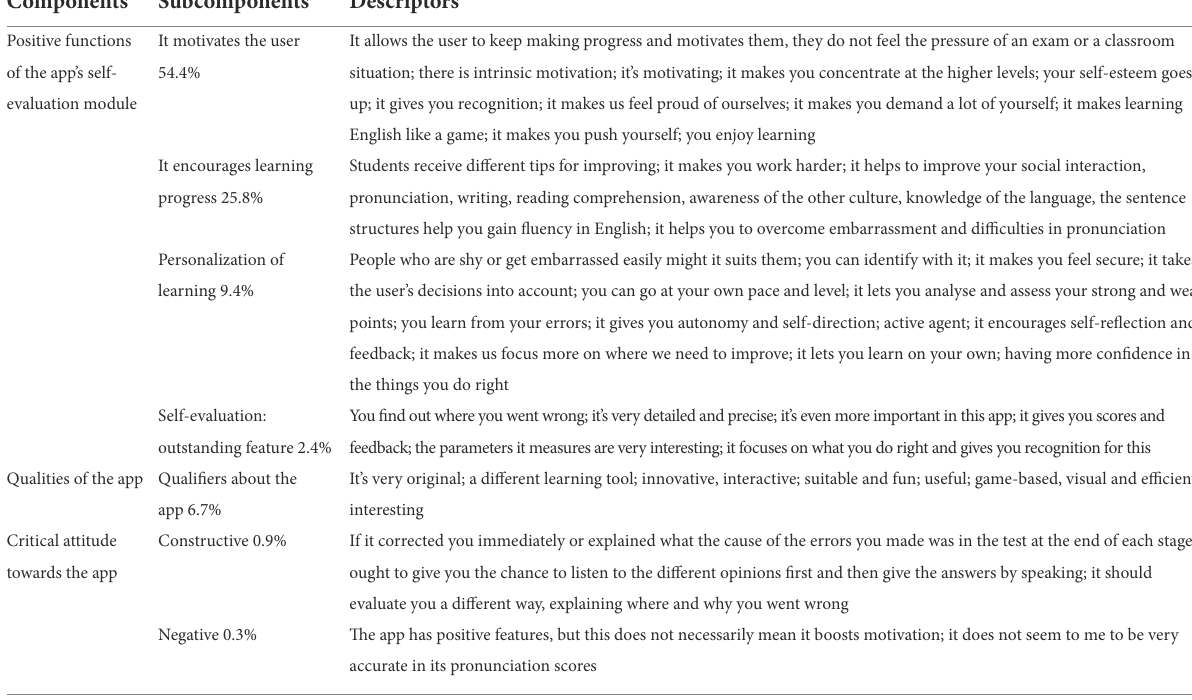
TABLE 4 Improving intrinsic motivation through the app’s self-evaluation module.